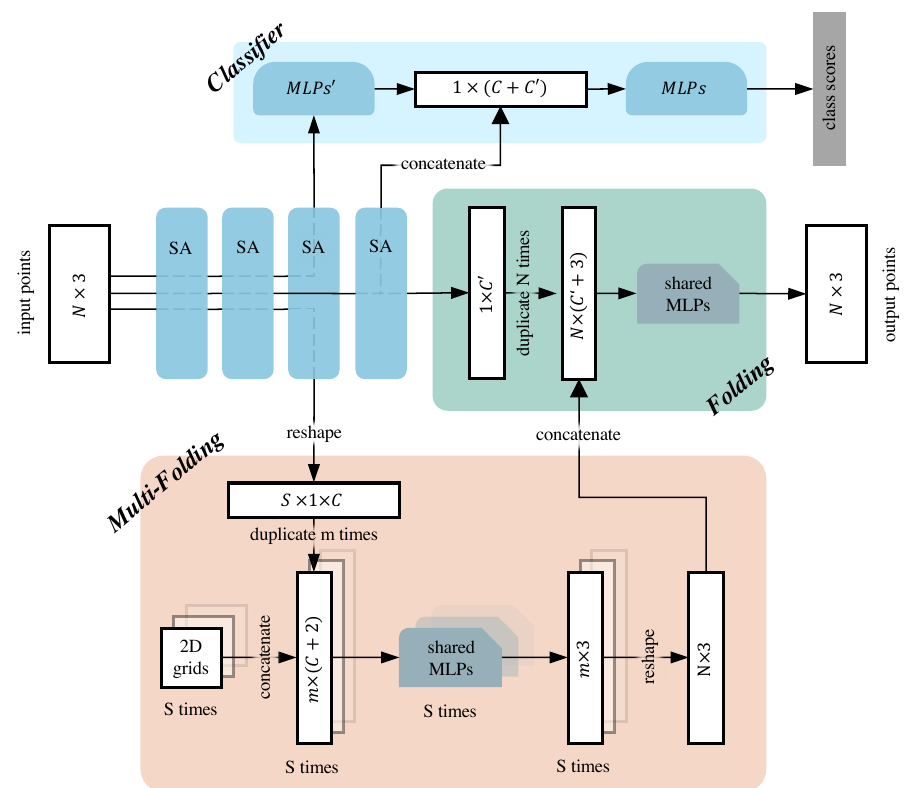
Figure 2. Overall framework of our model. Our proposed multigrid autoencoder consists of four self-abstraction (SA) modules with folding and multi-folding operations (see the second and third rows in the figure). Our proposed classification network consists of four SA modules and the classifier. For multi-folding, the shared multilayer perceptrons (MLPs) are three-layered, whose neurons are set to 514-256-64-3. For folding, the shared MLPs are also three-layered but set to 1027-256-64-3. The activation function is LeakyReLU, and batch normalization is added between each layer. Regarding the classifier, the MLPs’ consist of one MLP layer, and the variation in the number of neurons is S × C-512. There is also a three-layer MLP, whose variation in the number of neurons is 1536-512-128-k, where k represents the number of categories. Batch normalization and dropout are added between layers, and the activation function is LeakyReLU. Note that the solid line in the SA indicates that it is processed by the layer, and the dashed line in the SA indicates that the layer is